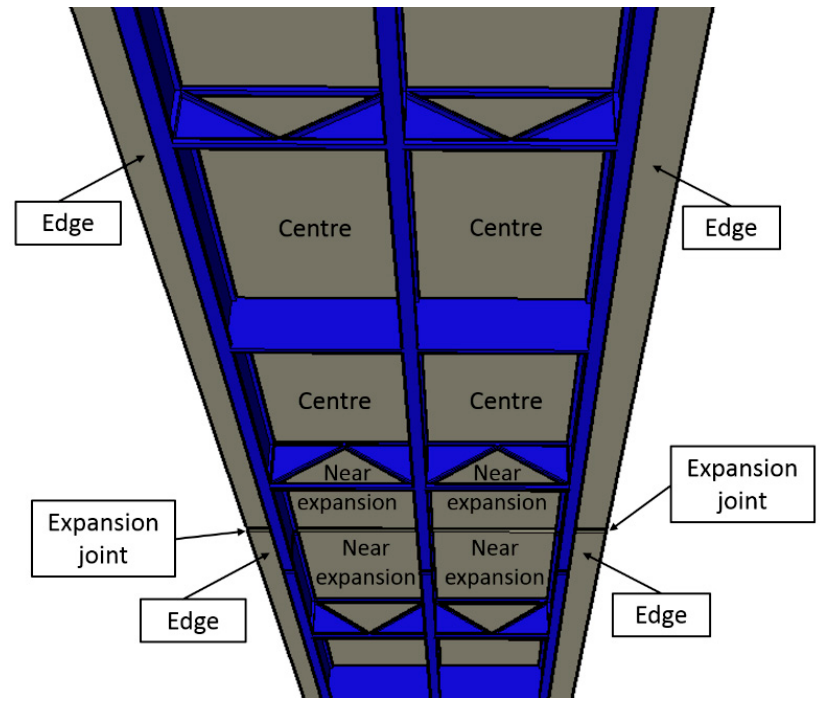
Figure 3. Definition of panel. Table 1 . Inspection standard of reinforced concrete (RC) deck slab panel in East Japan.